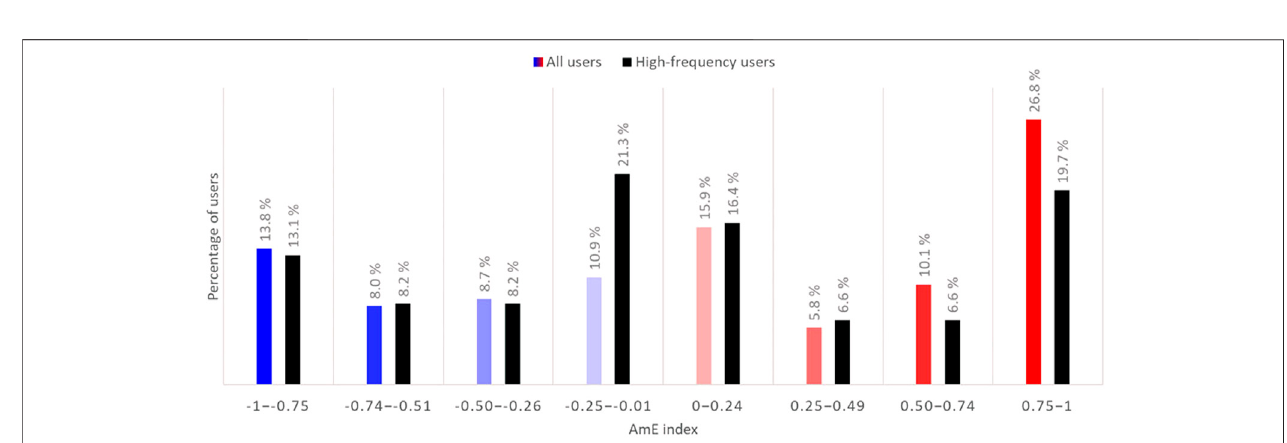
FIGURE 4 | A comparison of all users ( n (cid:1) 139) and users who have provided 10 or more hits ( n (cid:1) 61), all variables included.